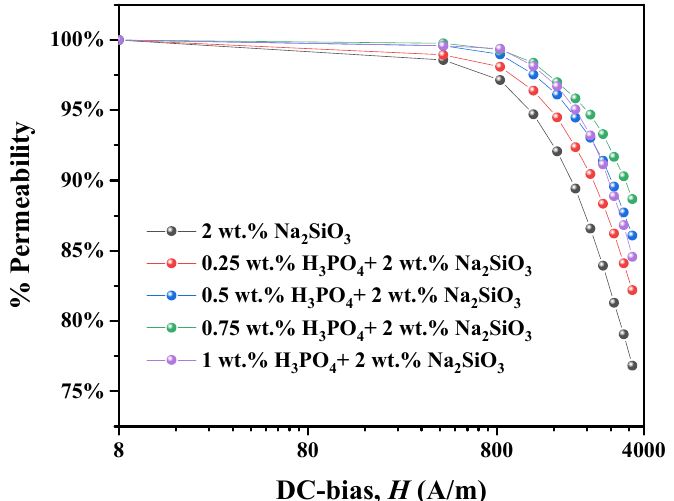
Figure 9. The variation of the permeability with the DC-bias field for SMCs after coating with different H 3 PO 4 concentrations.